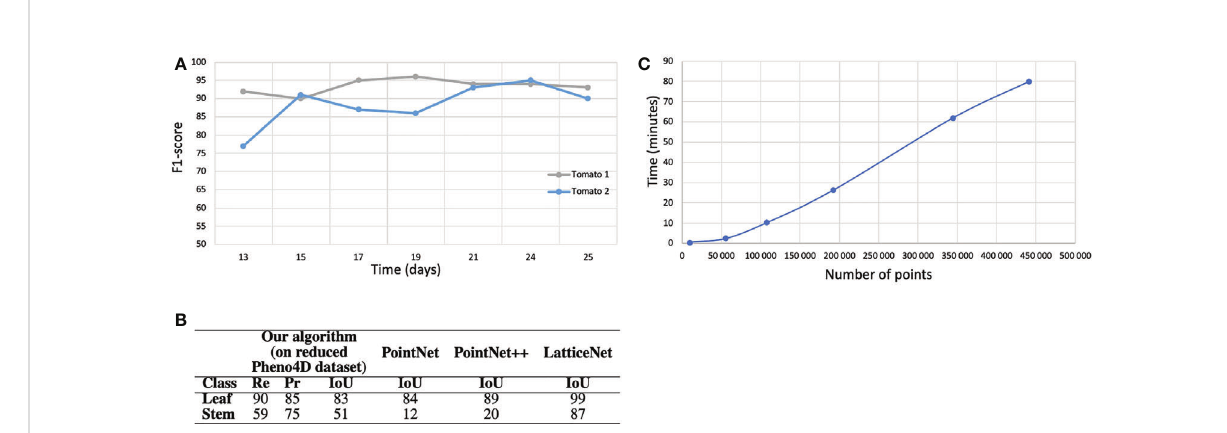
FIGURE 1 Semantic segmentation results on the tomato plant data set. (A) F 1 -score with respect to the stage of development of the tomato plants. (B) Semantic segmentation results (in % ) on the real tomato plant data set containing two plants at 7 stages of development each. Semantic segmentation IoU obtained by (Schunck et al., 2021) with three different neural network on the entire Pheno4D tomato data set. (C) Computation time with respect to the size of the point cloud (the four biggest point clouds correspond to the tomato